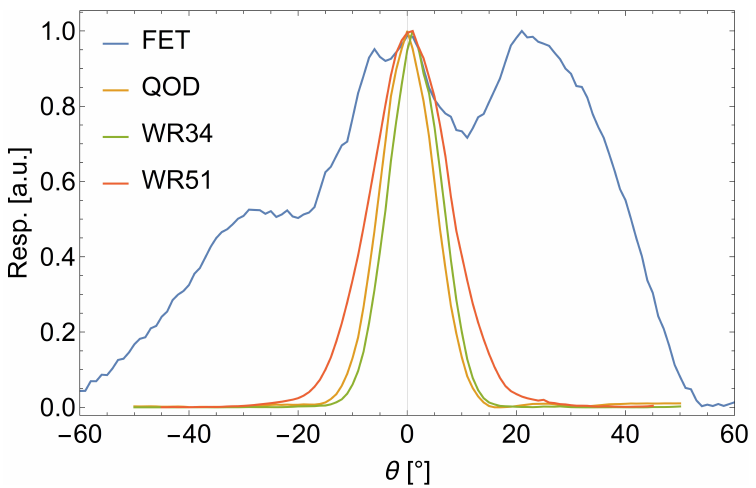
Figure 5. The comparison of the normalized angular acceptance characteristics obtained for the FET (at 260 GHz), QOD (at 140 GHz), WR34 (at 260 GHz) and WR51 (at 140 GHz) detectors, marked with the blue, orange, green and red lines,